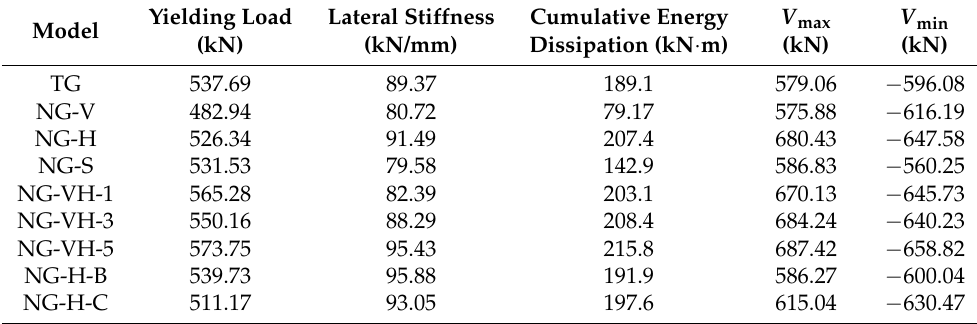
Figure 10. Numerical vs. experimental backbone curves. Table 2. Summary of the parametric study.